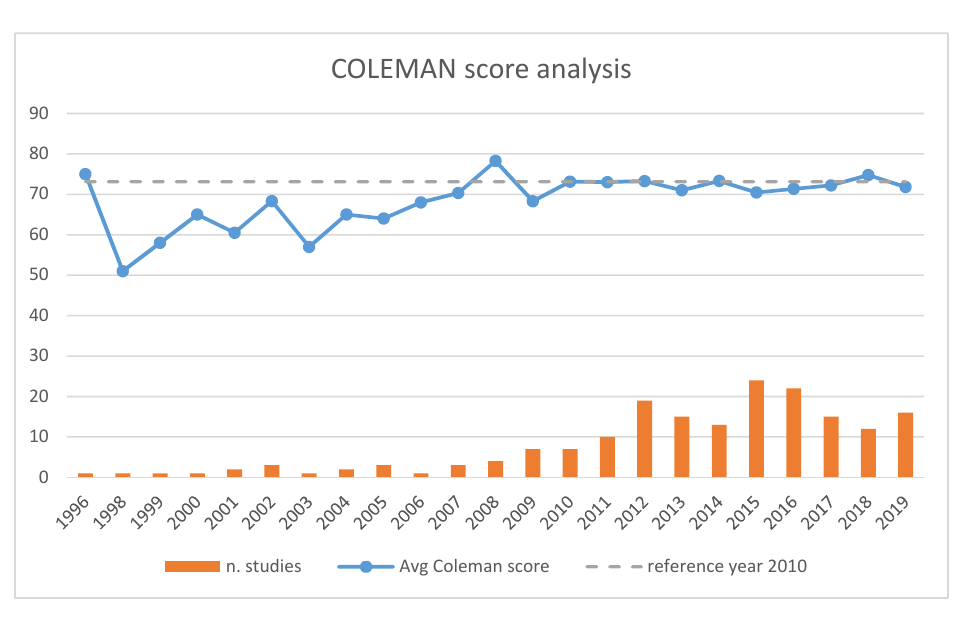
Figure 2. Coleman score analysis.